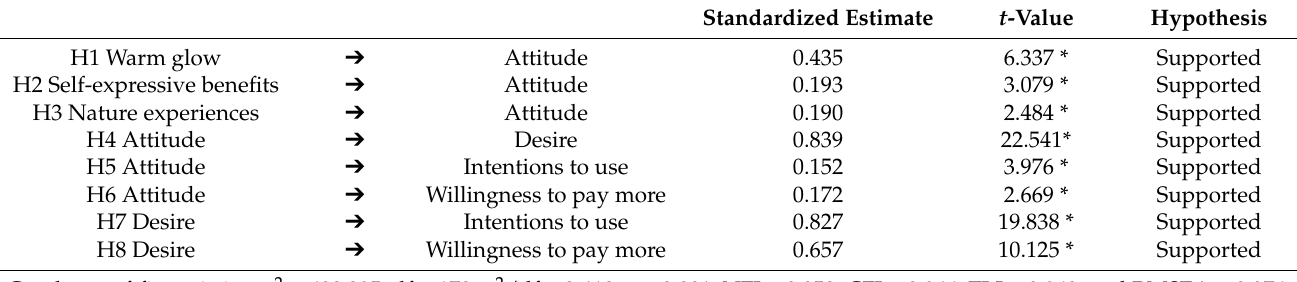
Table 4. Standardized parameter estimates for the structural model.